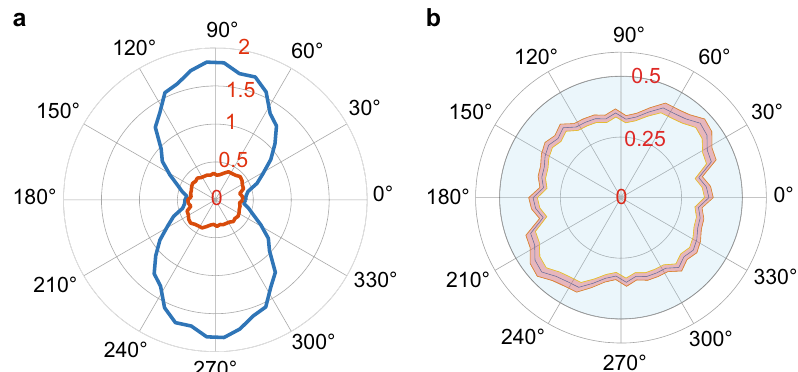
Þ = κ 2 (blue) and ð Var ð m 2 j m 1 ; m 3 ; m 4 Þ (cid:3) 1 2 2